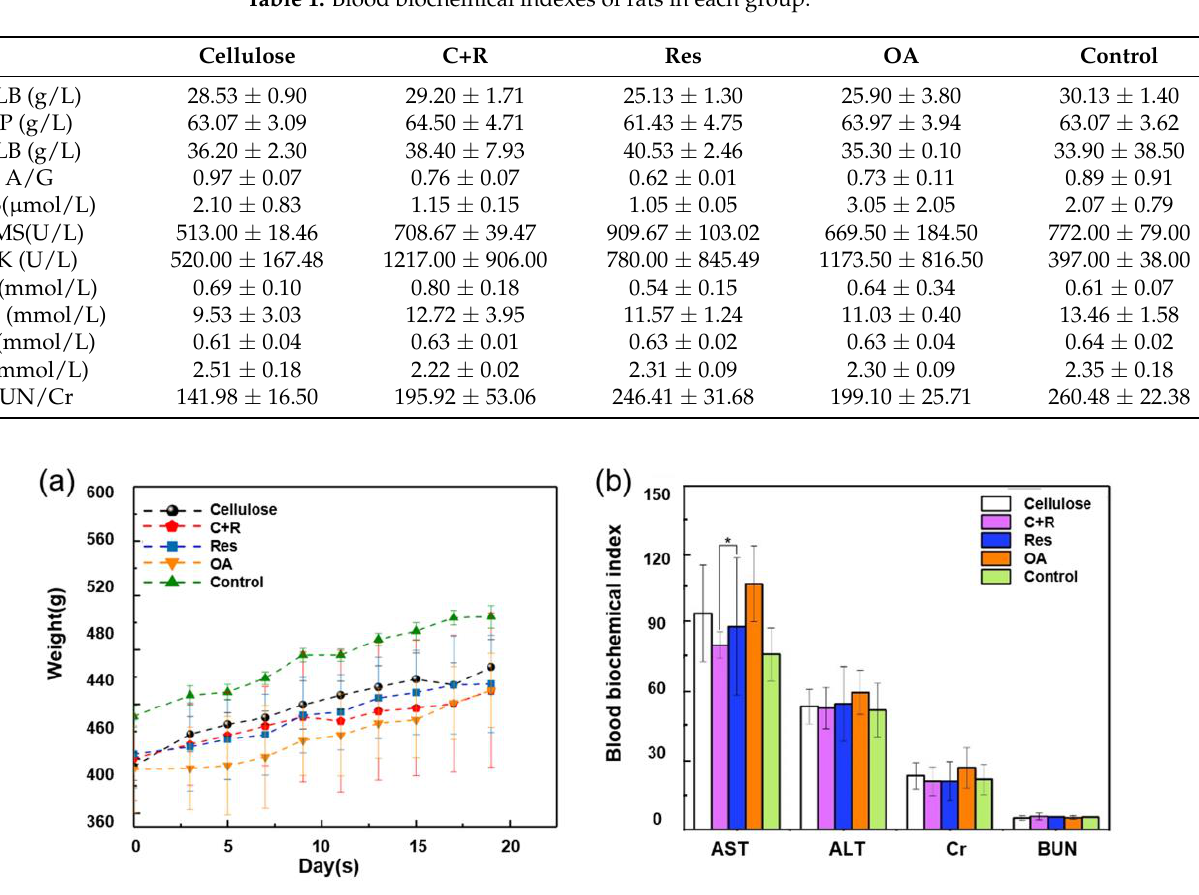
Figure 4. ( a ) The weight of the rats in each group during the whole experimental period. ( b ) Effect of administration on liver function (AST, ALT) and renal function (Cr, BUN) of rats. (* p < 0.05). Table 1. Blood biochemical indexes of rats in each group.